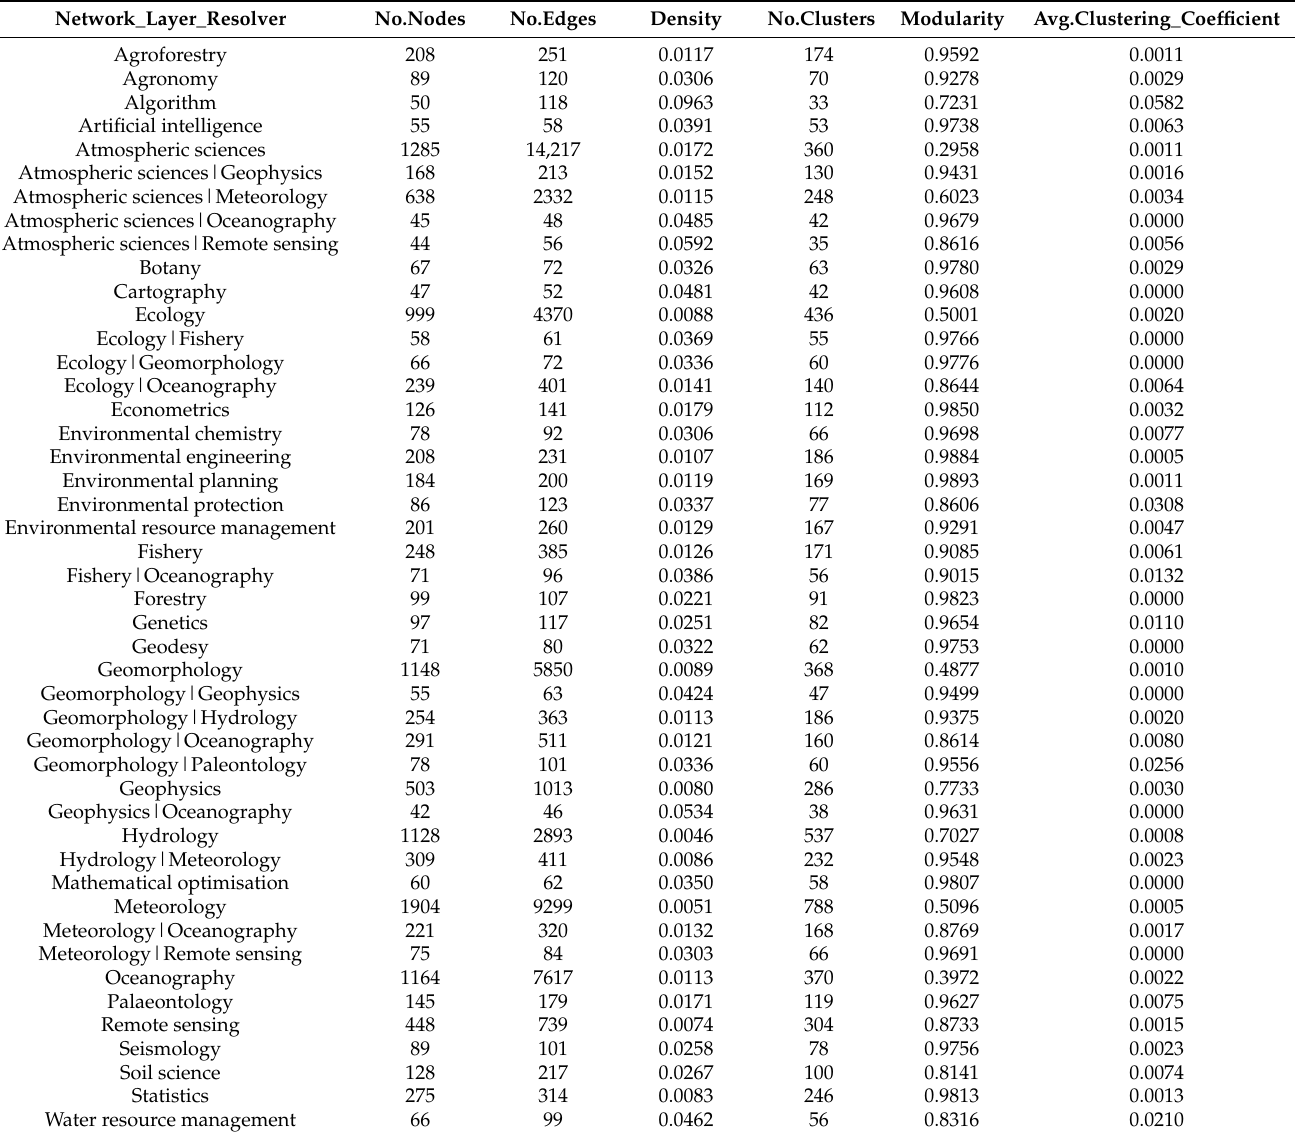
Table 2. Layer metrics of the institutional